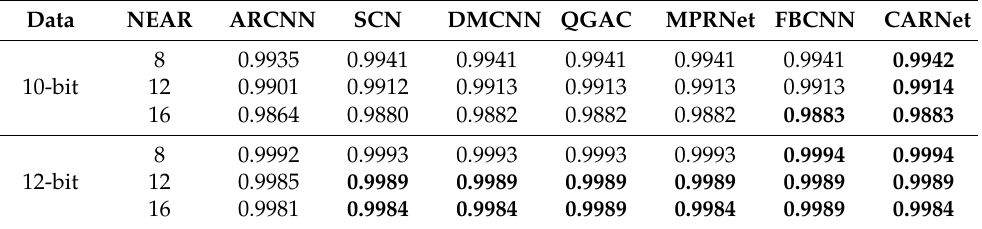
Table 3. SSIM results, data type: 10-bit (NEAR = 8) means a 10-bit remote sensing image compressed by JPEG-LS with a NEAR value set to 8. Best results bold.